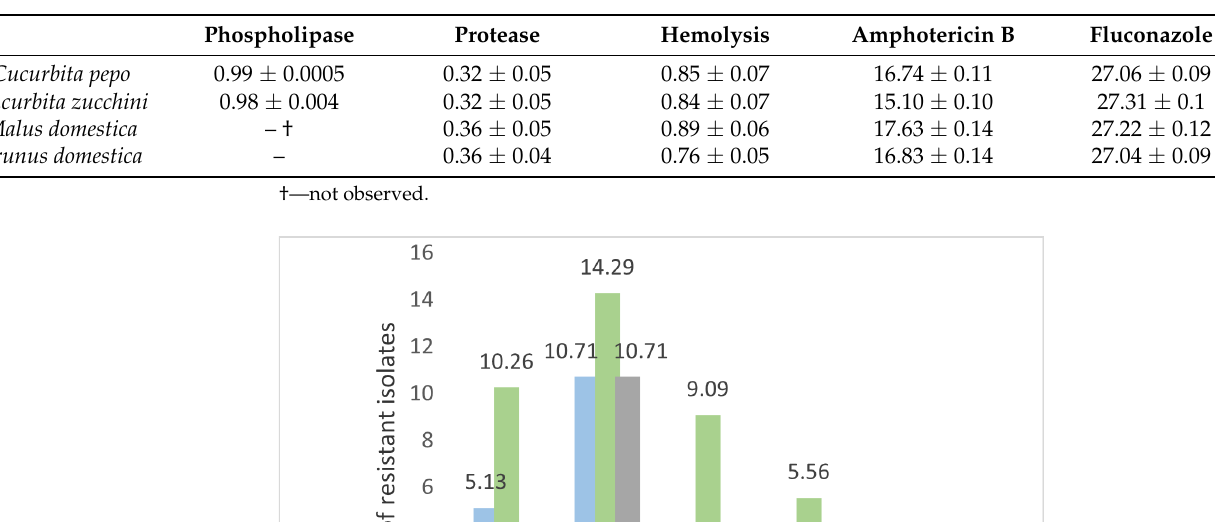
Table 5. Mean Pz value of hydrolytic enzymes and growth retardation zone (mm) for endophytic strains of Candida parapsilosis isolated from ripe vegetables and fruits.